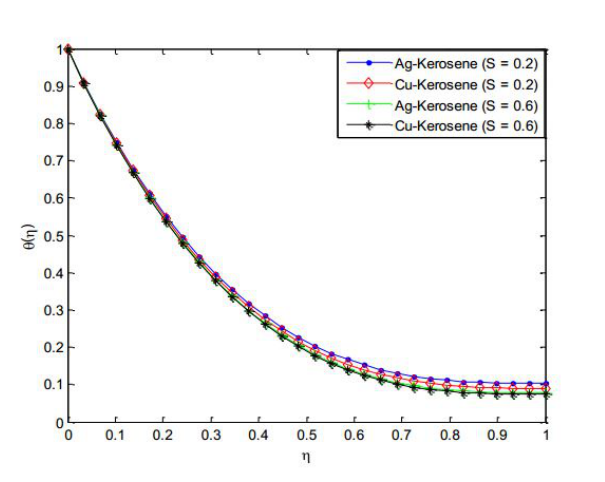
Figure 9. Effect of unsteadiness parameter on the fluid temperature